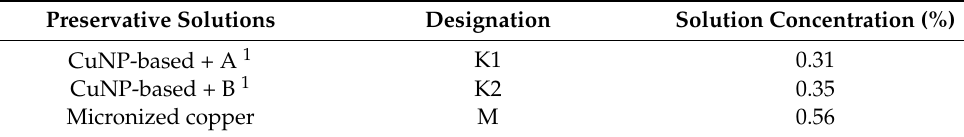
Table 1. Preservative solution concentrations used in radiata pine wood impregnation. Preservative